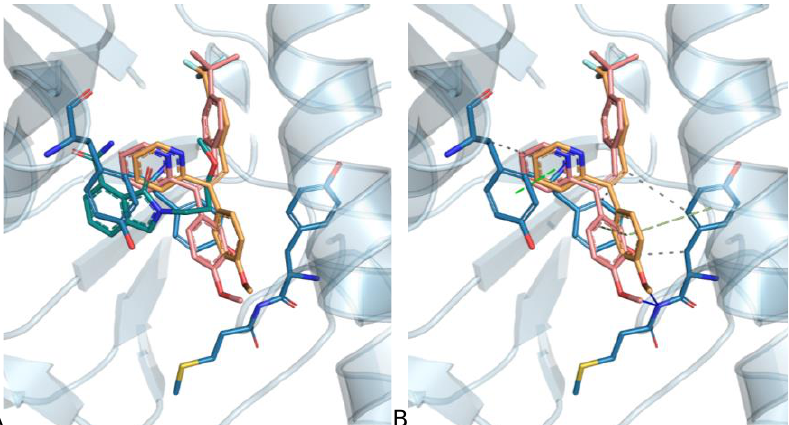
Figure 12. Predicted binding modes of compounds 12a (in orange) and 10a (in salmon) in the PARP binding site (PDB ID: 4ZZZ) ( A ) in comparison with the 4ZZZ co-crystallized ligand (in blue) and ( B ) with detailed information about the interactions established between our compounds and the PARP binding site obtained using PLIP [53 ] (plain line blue: HB; green dotted lines: π - stacking; grey dotted lines: hydrophobic.